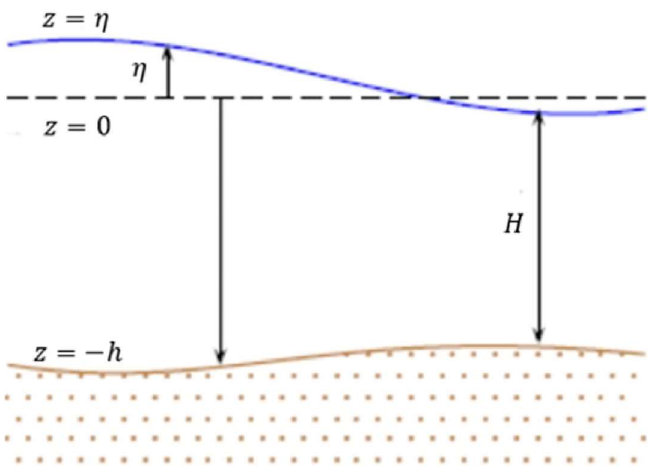
Figure 3. Geometry of a typical water column.